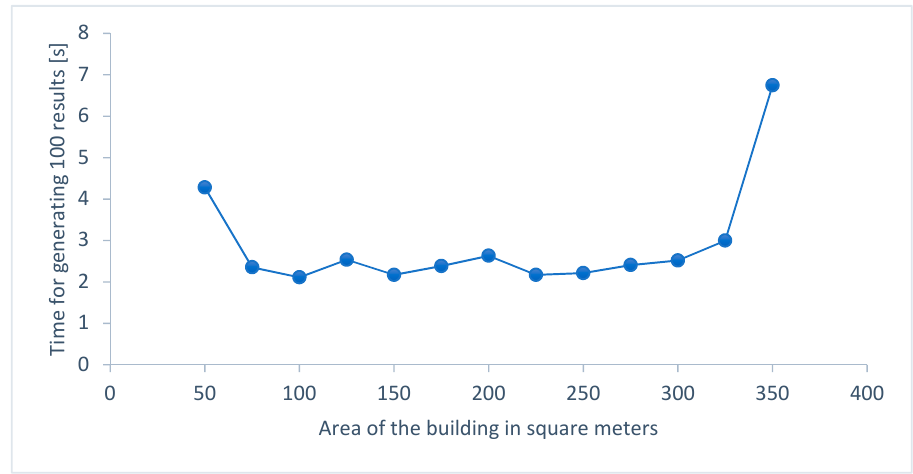
Figure 8. Performance of the method. The graph presents the correlation between the input parameter that represents the area of the building and the average time for generating 100 results. Performance is worse for areas that are lesser than 75 or greater than 325.